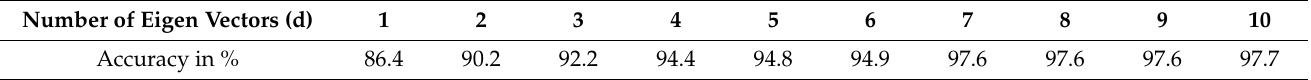
Table A2. Accuracy obtained using p = 35 and different number of eigen vectors